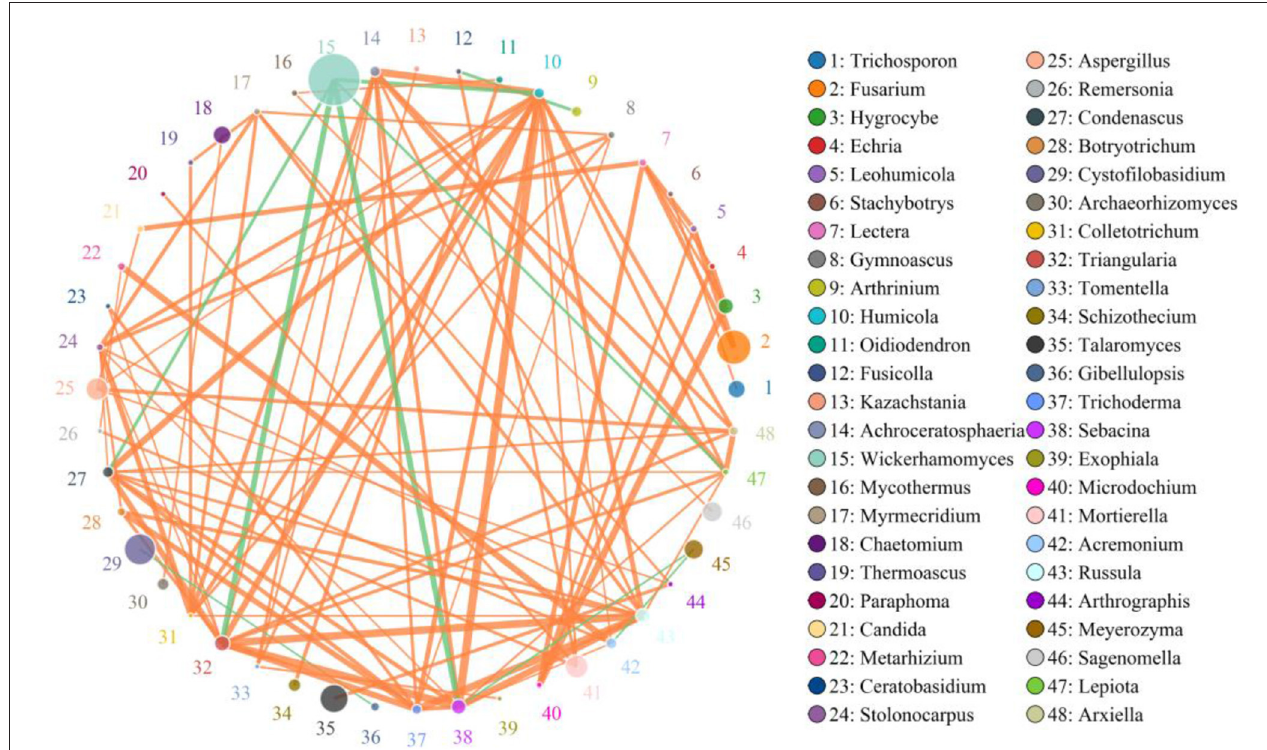
FIGURE 9 | Network diagram of fungi at the genus level in the gut of Baer’s pochard. The circles with different colors represent different genera, and the circle size represents the average abundance of each genera. The thickness of the line between two circles represents the strength of the correlation. The orange line represents the positive correlation, while the green line represents the negative